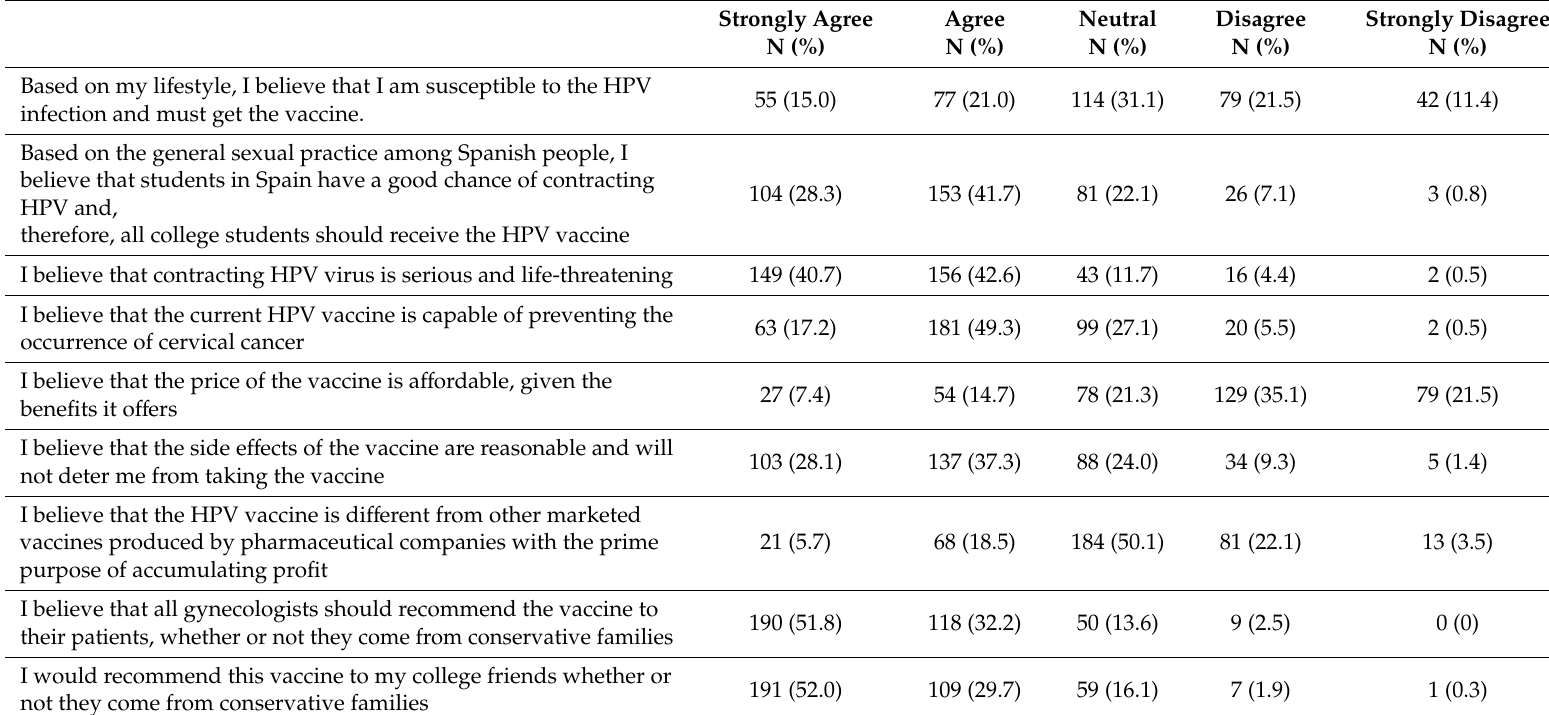
Table 4. Attitudes towards HPV infection and its